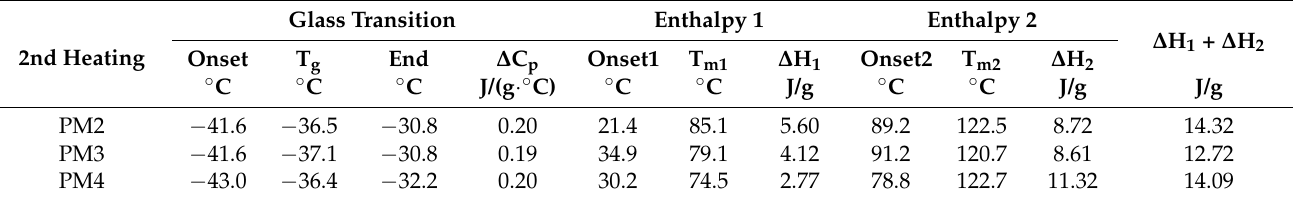
Table 7. Cooling of mechanically recycled compounds.